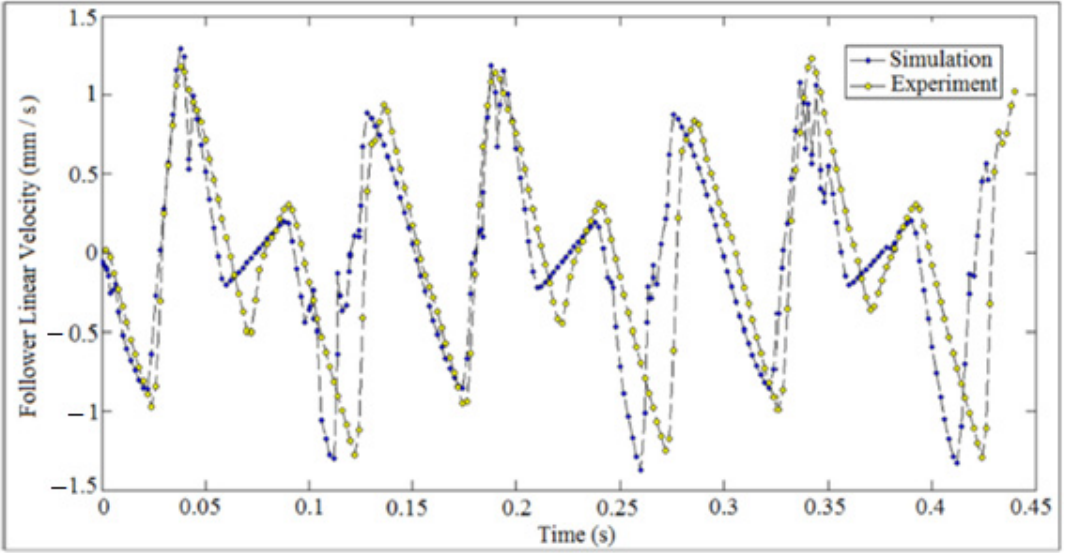
Figure 39. Comparison of follower linear velocity against time.